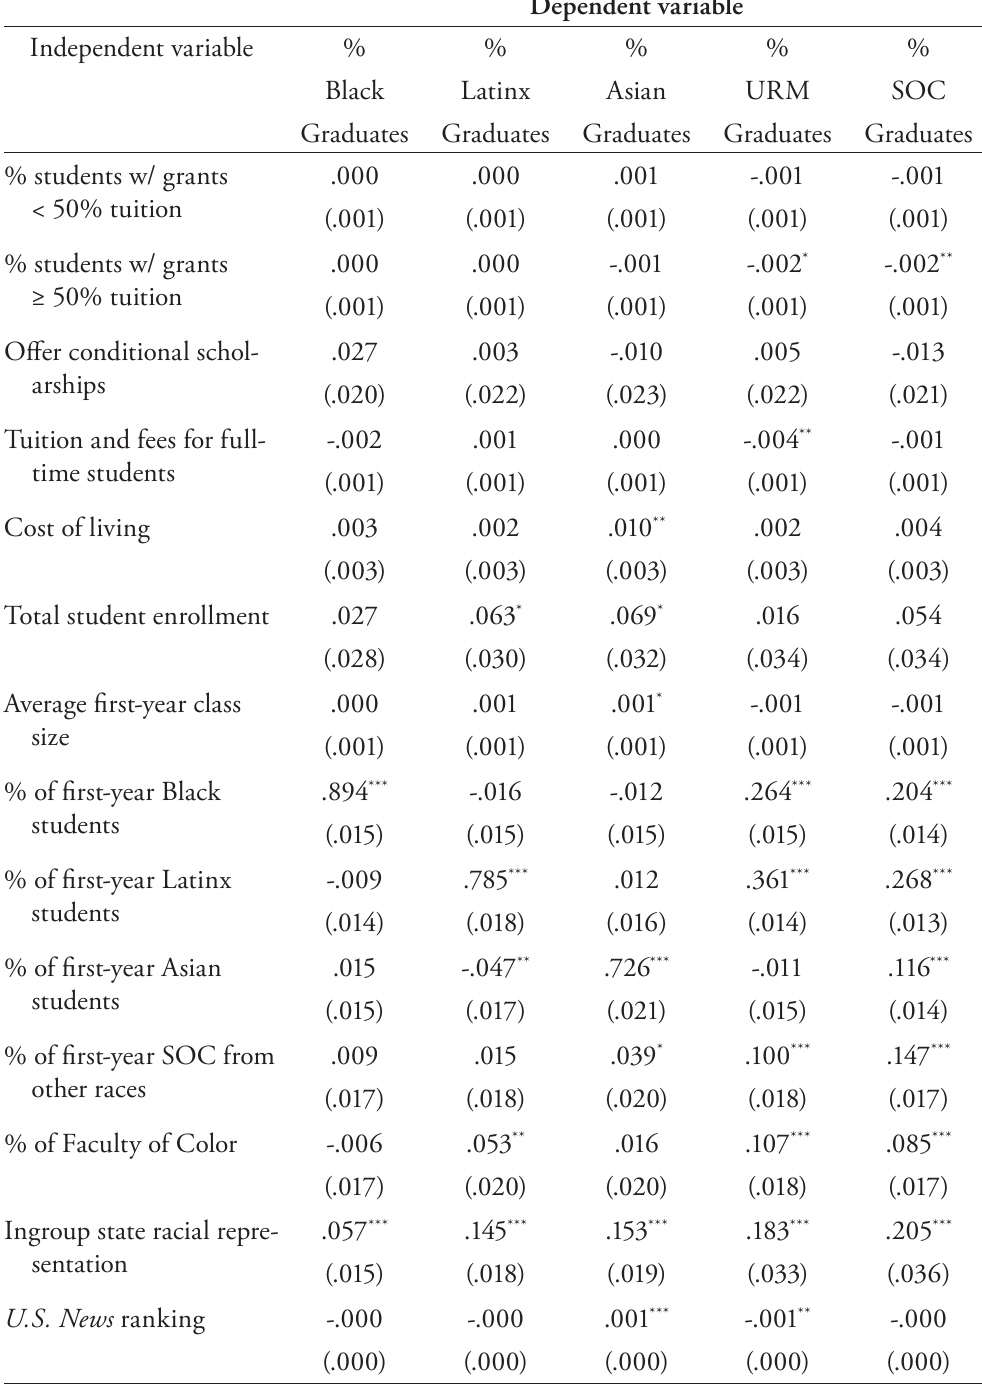
Table 2. Unstandardized Coefficients for Random Effects Analyses